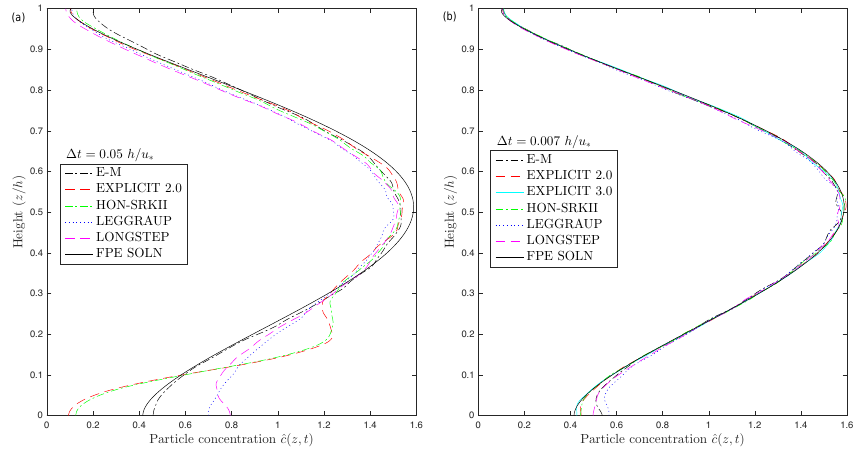
Figure 7. Snapshots of reconstructed particle density b c(z,t) for the stable ABL case at time t = h/u ∗ , shown at each scheme. (a) When long time step (cid:49)t = 0 . 05 h/u ∗ is used and errors due to boundary conditions dominate. (b) When moderate time step (cid:49)t = 0 . 007 h/u ∗ is